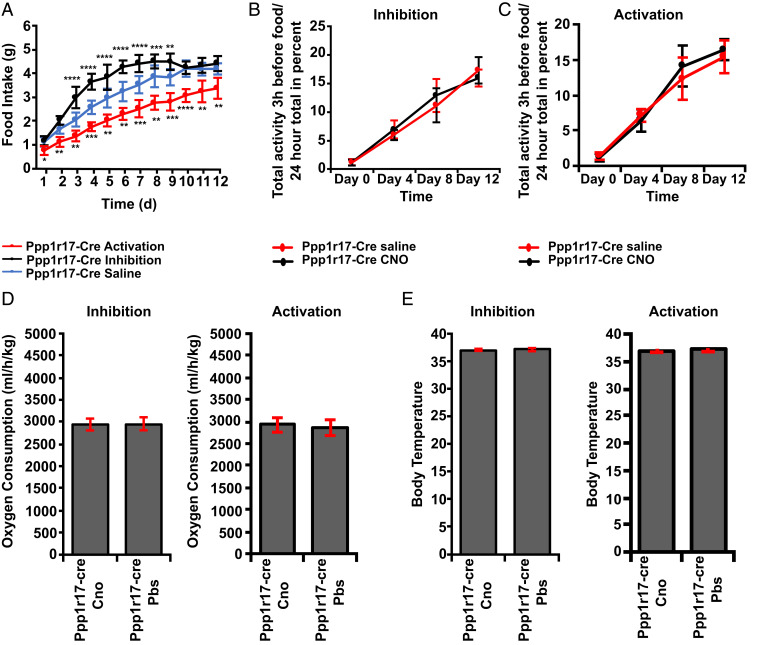
Effect of chemogenetic modulation of DMHPpp1r17 neurons on food intake, body weight, and FAA during scheduled feeding. (A) DREADD-induced activation (treatment P < 0.0001) and inhibition (treatment P < 0.0001) of DMHPpp1r17 neurons significantly alters food intake during scheduled feeding after i.p. injection of CNO 4 h before food presentation. Two-way repeated-measures ANOVA comparing treated and control groups. (B) DREADD-induced inhibition of DMHPpp1r17 neurons does not affect FAA. (C) DREADD-induced activation of DMHPpp1r17 neurons does not affect FAA. (D) DREADD-induced activation or inhibition does not alter oxygen consumption during scheduled feeding. Two-tailed unpaired t test comparing treated (Ppp1r17-cre CNO) and control group (Ppp1r17-cre PBS; E). DREADD-induced activation or inhibition does not alter body temperature during scheduled feeding. Two-tailed unpaired t test comparing treated (Ppp1r17-cre CNO) and control group (Ppp1r17-cre PBS; n = 8 mice; *P < 0.05, **P < 0.01, ***P < 0.001, and ****P < 0.0001). All error bars are mean ± SD.